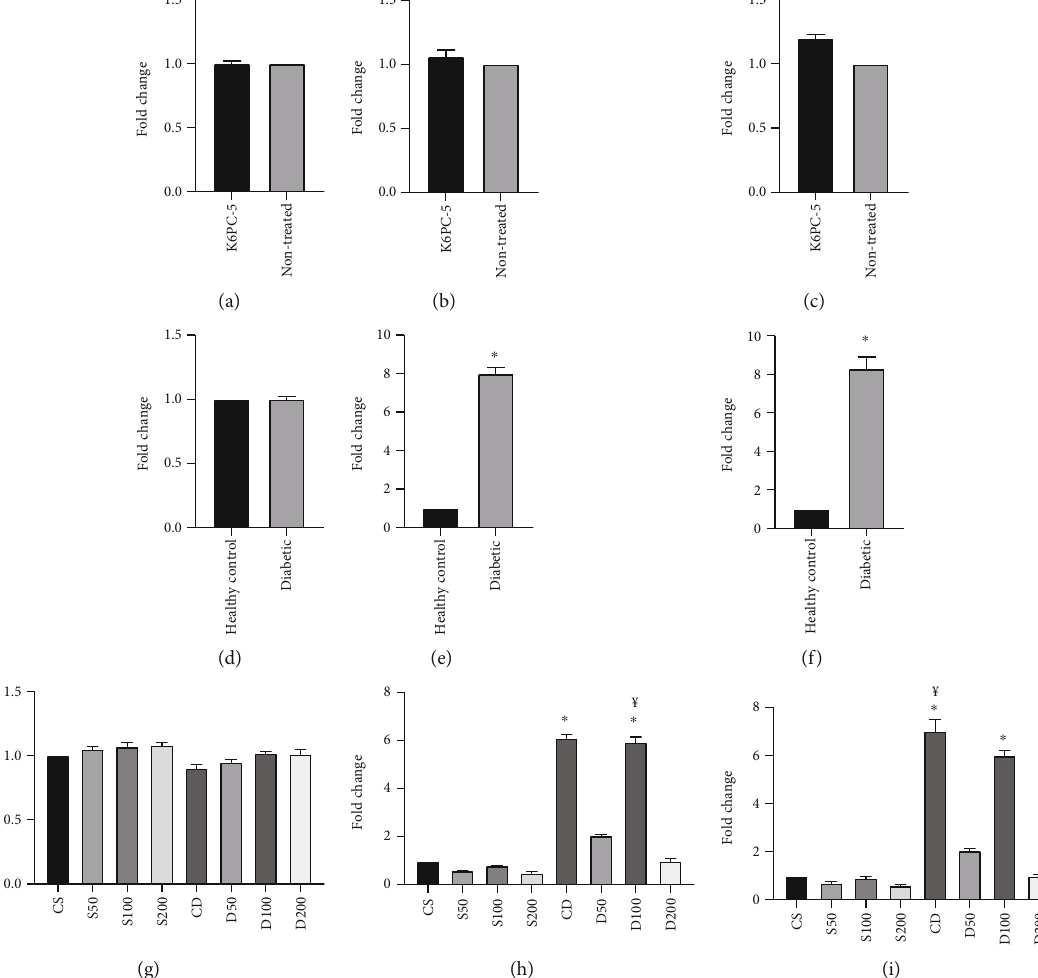
Figure 4: (a) Comparison of fi rst day ’ s fold changes of blood samples of groups, considering nontreated group equal to 1 (other group is shown proportional to the nontreated group). (b) Comparison of last day ’ s fold changes of blood samples of groups, considering nontreated group equal to 1 (other group is shown proportional to nontreated group, ∗ p < 0 : 05 ). (c) Comparison of last day ’ s fold changes of cardiac tissue samples of groups, considering nontreated group equal to 1 (other group is shown proportional to nontreated group, ∗ p < 0 : 05 ). (d) Comparison of fi rst day ’ s fold changes of blood samples of groups, considering healthy group equal to 1 (other group is shown proportional to the healthy group). (e) Comparison of last day ’ s fold changes of blood samples of groups, considering healthy group equal to 1 (other group is shown proportional to the healthy group, ∗ p < 0 : 001 ). (f) Comparison of last day ’ s fold changes of cardiac tissue samples of groups, considering the healthy group equal to 1 (other group is shown proportional to the healthy group, ∗ p < 0 : 001 ). (g) Comparison of fi rst day ’ s fold changes of blood samples of groups, considering the CS group equal to 1 (other group is shown proportional to CS). (h) Comparison of last day ’ s fold changes of blood samples of groups, considering the CS group equal to 1 (other group is shown proportional to CS, ∗ p < 0 : 001 , ¥ D50 vs. D200 p < 0 : 05 ). (i) Comparison of last day ’ s fold changes of cardiac tissue samples of groups, considering the CS group equal to 1 (other group is shown proportional to CS, ∗ p < 0 : 001 , ¥ D50 vs. D200, p < 0 : 05